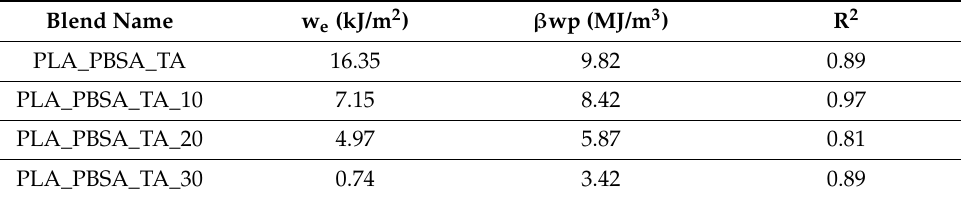
Figure 9. Specific total work of fracture w f versus ligament length l for plasticized PLA/PBSA blend with and without bran. Table 5. EWF fracture parameters for PLA/PBSA blends with and without